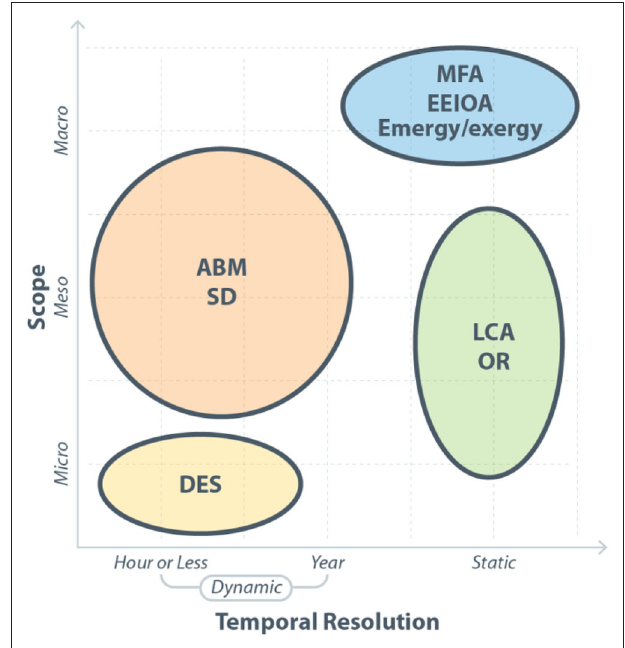
FIGURE 4 | Scope and temporal resolution of reviewed methods. Industrial ecology methods are static methods, although they may be modified to include temporal aspects while complex systems science methods are dynamic. Both fields include methods that are more appropriate to the micro, meso, and macro scales. ABM, agent-based modeling; SD, system dynamics; MFA, material flow analysis; EEIOA, environmentally extended input-output analysis; LCA, life cycle assessment; OR, operations research; DES, discrete event